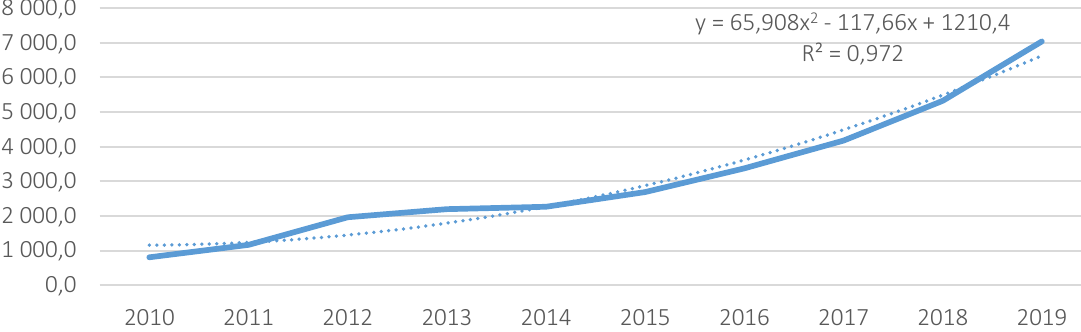
Figure 14. Determination of the type of growth curve for the volume of gross premiums of voluntary health insurance in Ukraine in 2010–2019